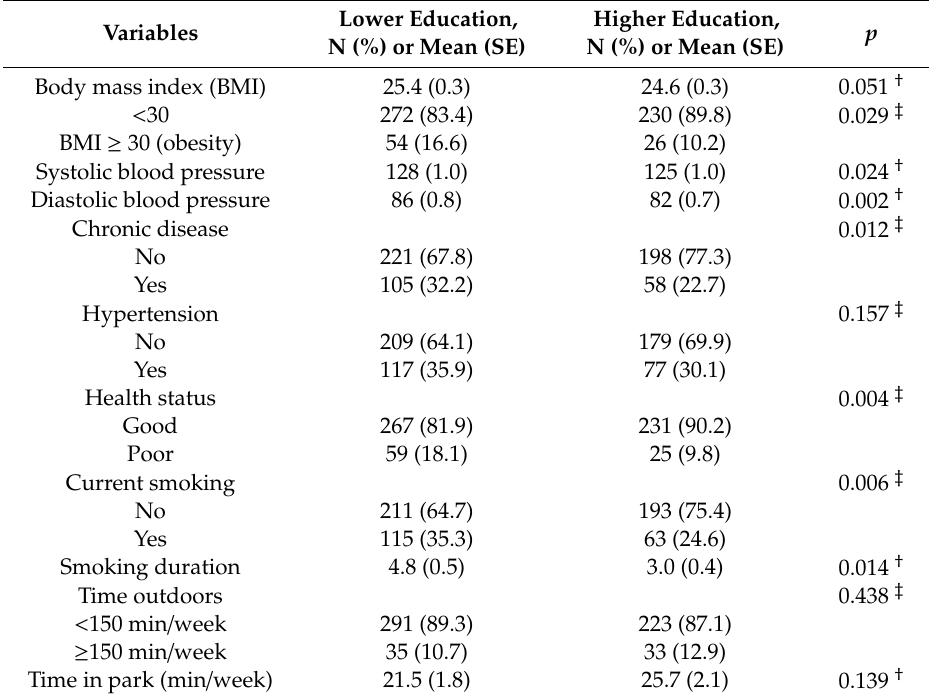
Table 2. Self-reported health characteristics in groups of participants by education